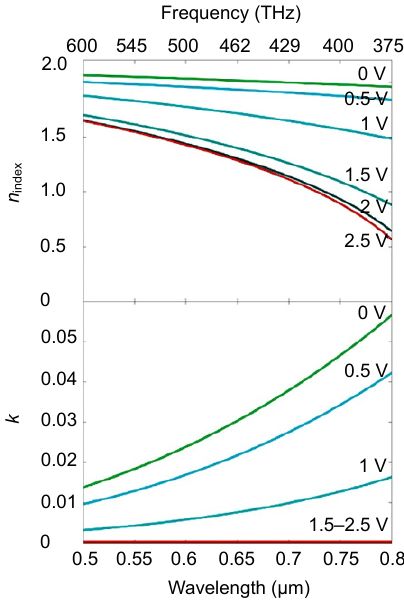
Fig. 3 | The refractive index ( n ) and extinction coefficient ( k ) in a 5 nm accumulation layer, extracted data from the ellipsometry measurements. Figure reproduced from ref. 119 , American Chemical Society.